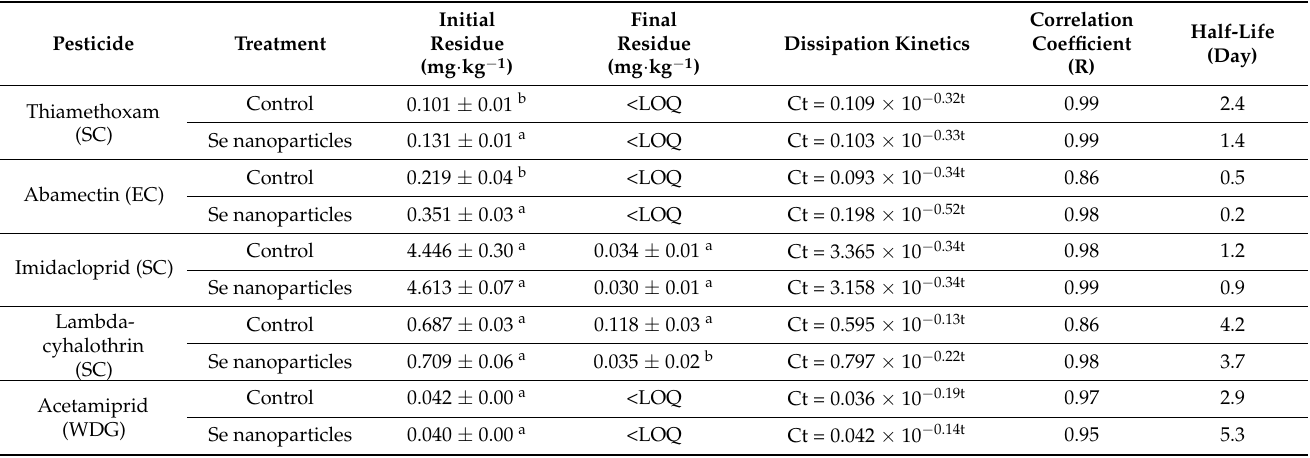
Table 7. Dissipation kinetics and half-lives of five pesticides in celery at the recommended dose combined with 2 g · ha − 1 Se